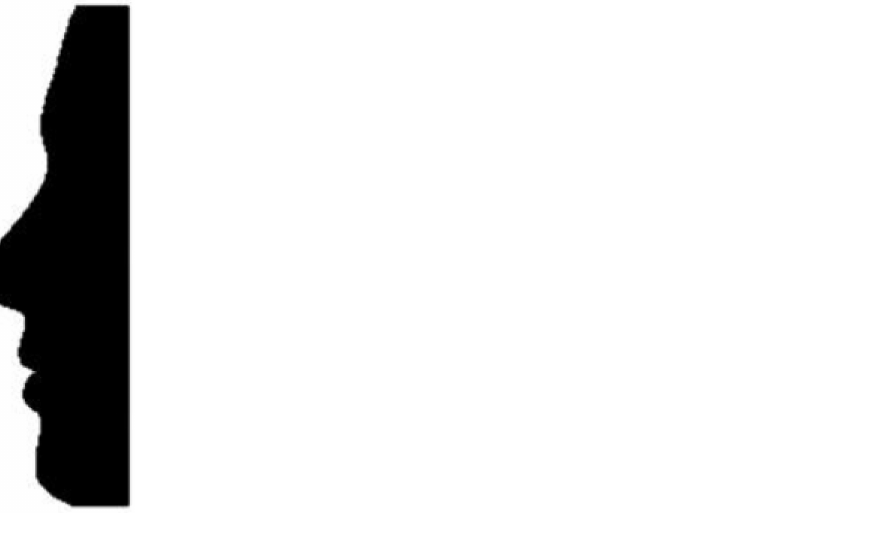
Figure 1. Gender-neutral silhouette [58] presented to all participants.